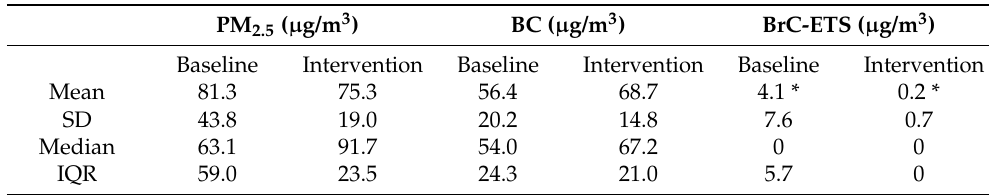
Table 2. PM 2.5 , BC, and BrC-ETS concentration distributions measured during the baseline and intervention